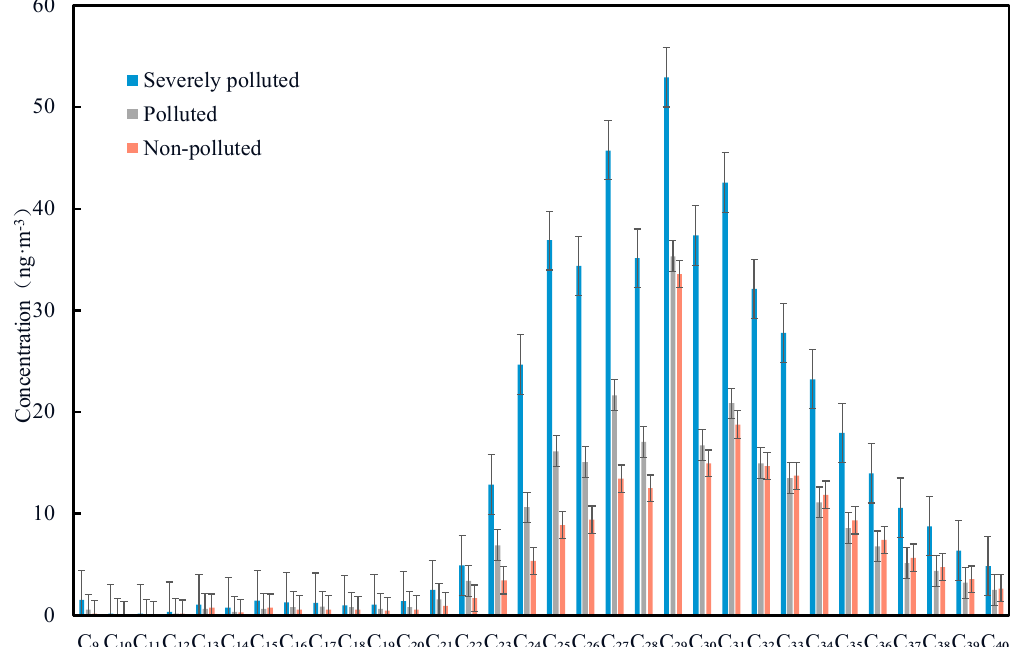
Figure 3. Carbon number distribution patterns for n-alkanes in different polluted days.